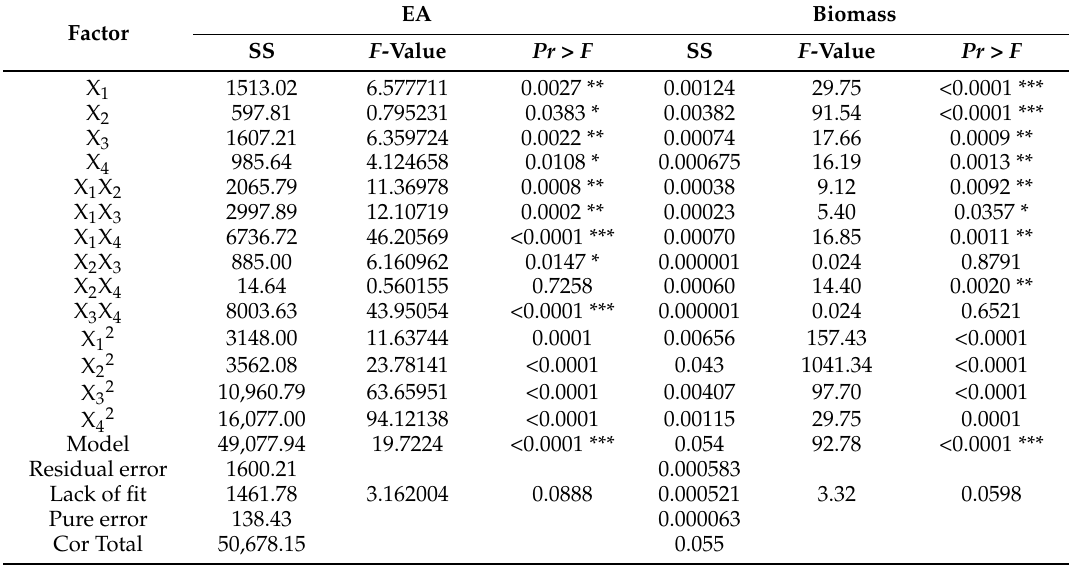
Table 5. ANOVA for response surface polynomial model of all independent